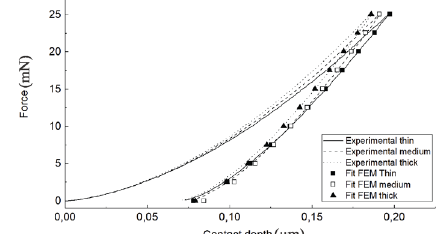
Fig. 11 Force displacement curves measured normal to the coating surface (dotted lines) and best fit result from the FEM model for the measurement of coatings with different thicknesses deposited at the medium